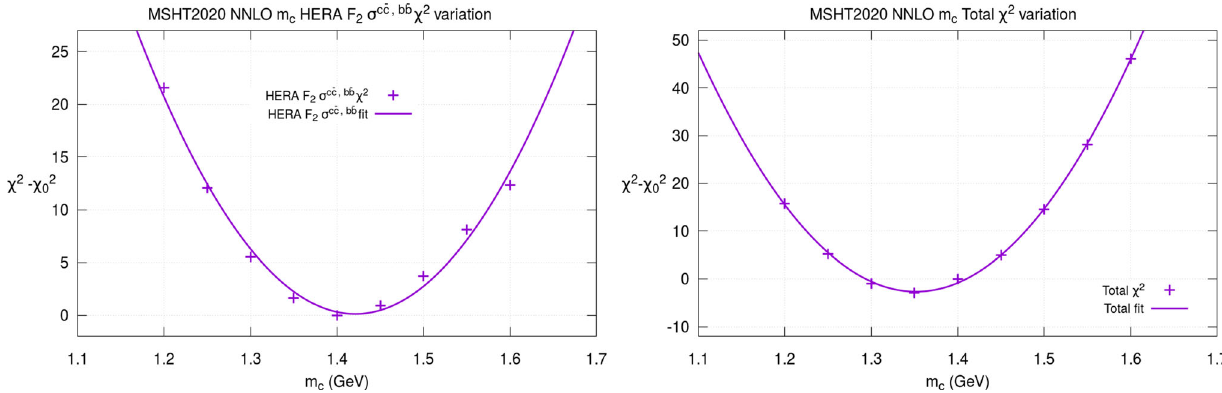
) = 0 . 118 for (left) the reduced cross section for charm and bottom Z